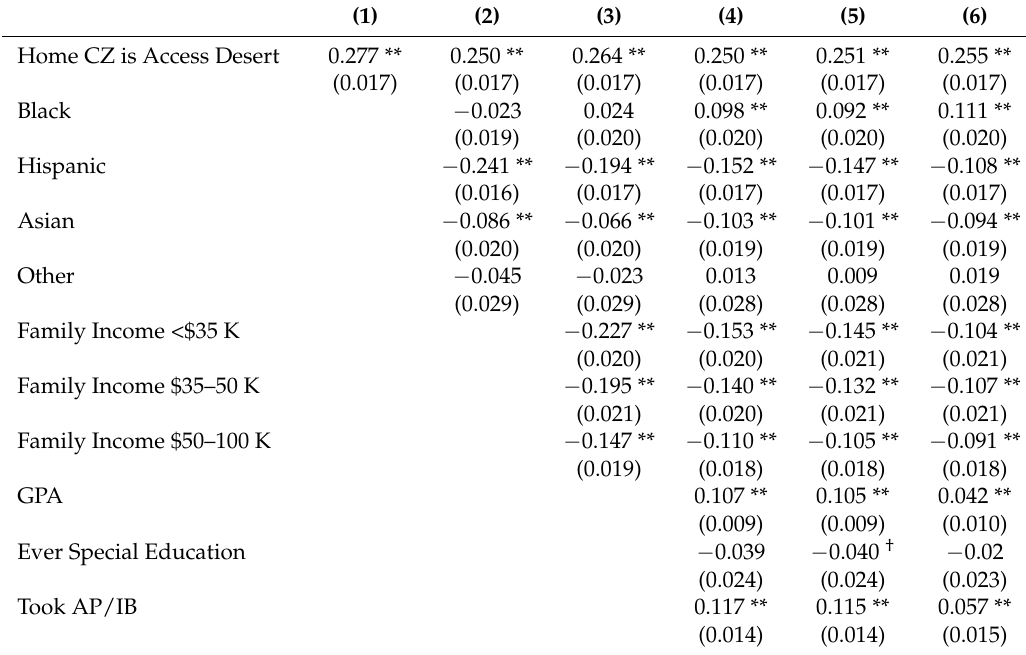
Table A2. Relationship between living in an access desert and enrolling in a college outside of home commuting